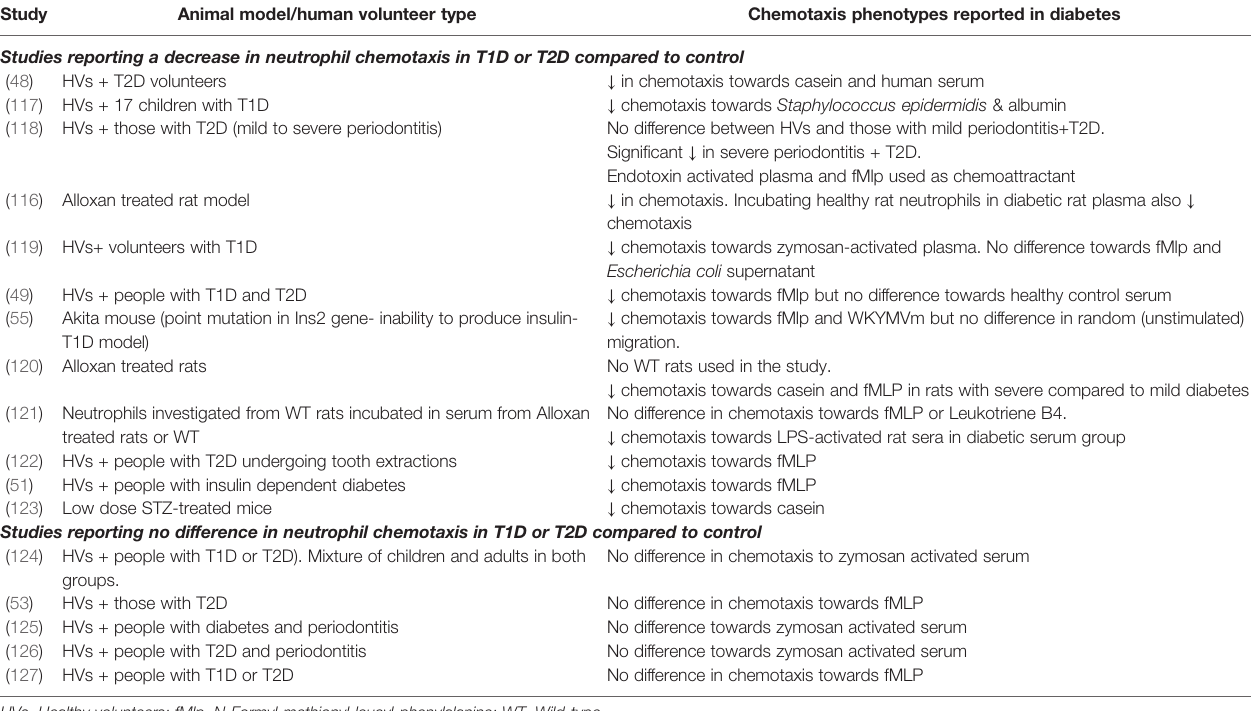
TABLE 1 | Studies investigating neutrophil chemotaxis in